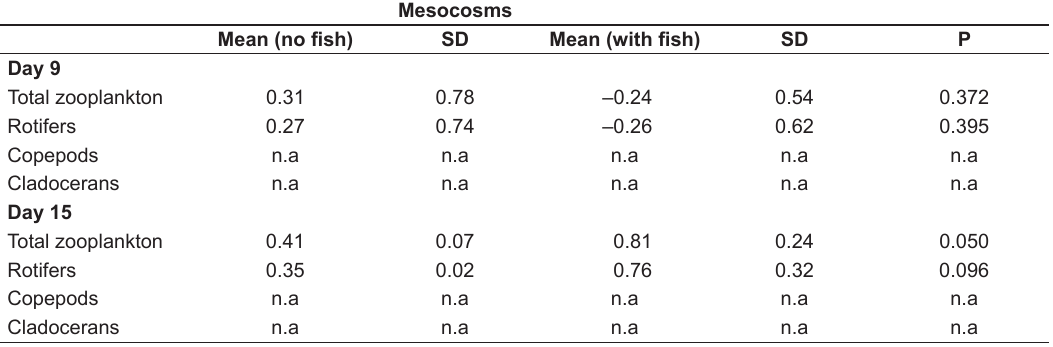
Table 3. Mean and standard deviation (SD) of the net changes in zooplankton density of the major groups in the mesocosms, on days 9 and 15 of the experiment, and the t test results for differences of net changes between the treatment A (fish+) and the treatment B (fish–) ( p <0.05); n.a = not assessed.